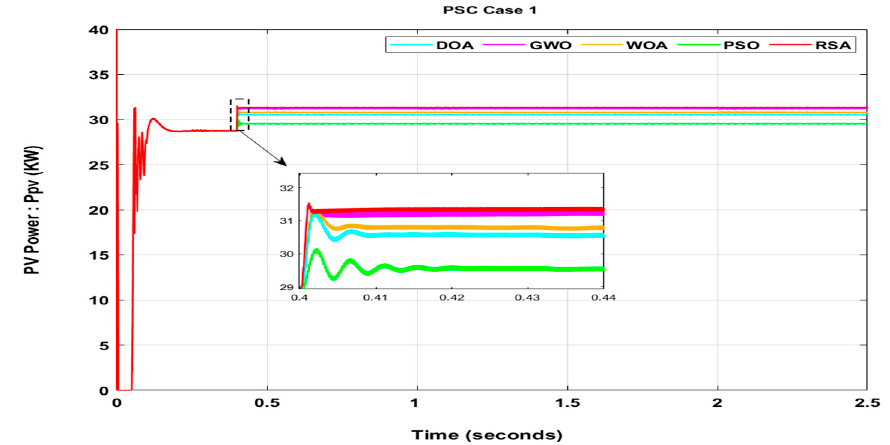
Figure 7. PV output power under PSC case 1. Case 2: only one of the PV arrays (PV3) is partially shaded while the other two ar- rays receive the same level of irradiance. However, the di ff erence in irradiance level be- tween the arrays is small compared to Case 1. The PV curve (Figure 2b) exhibits the same behavior as Case 1, with a global maximum power of 64.19 KW.